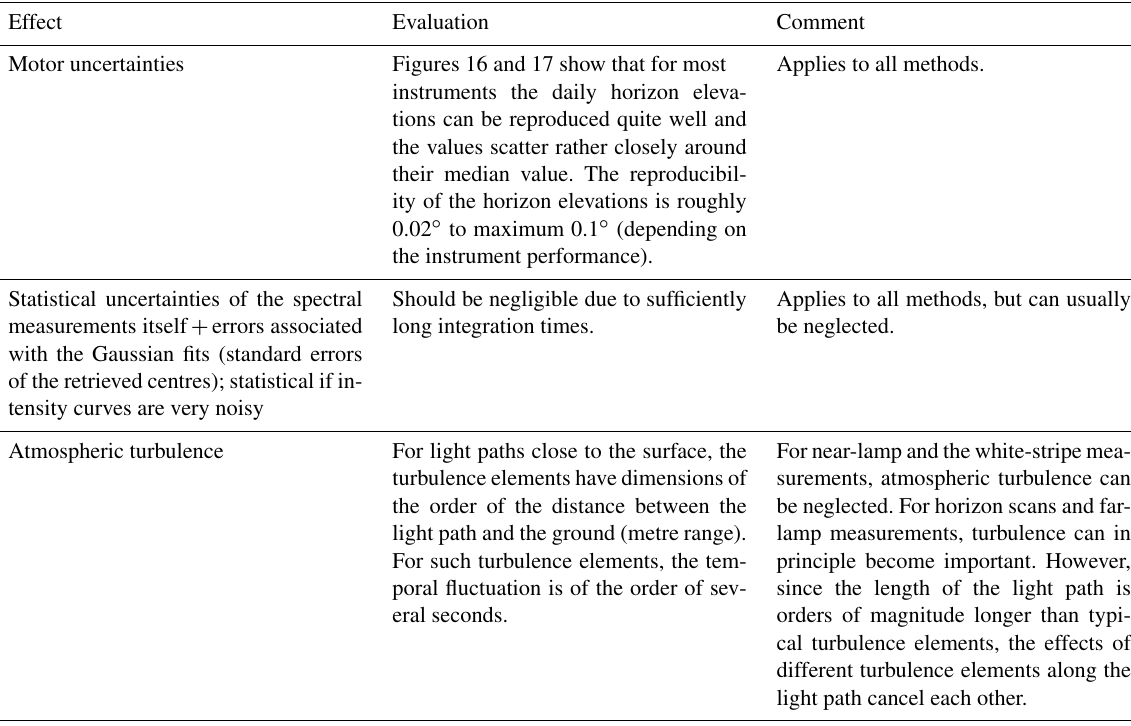
Table A2. List and evaluation of statistical effects influencing the measurements presented in this